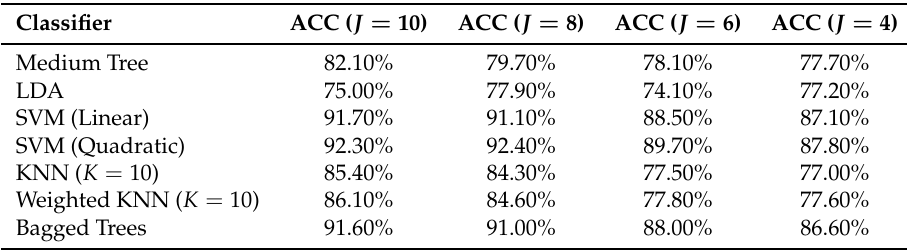
Table 4. Classification accuracy comparison of different classifiers using wavelet features with varied levels of filterbanks.